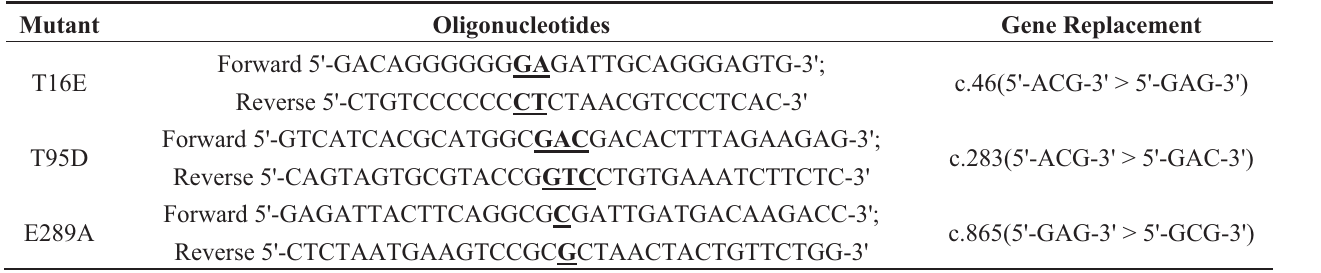
Table 2. Sense and anti-sense oligonucleotides used for mutagenesis experiments on the ansB wild type gene. Bold underlined letters represent replaced